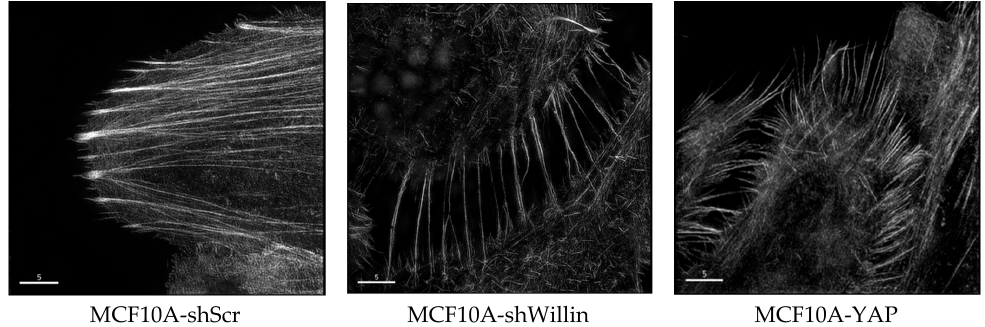
Figure 2. Structured illumination microscope images of Fluor568 phallodin stained actin cytoskeleton of MCF10A cells expressing either shScr (scramble control), shWillin or YAP, indicating that a knockdown of willin expression appears to phenocopy increased YAP ‐ induced filopodia formation [63]. Images taken by Dr S Moleirinho and Dr M Posch (University of Dundee) on an OMX microscope (scale bar, 5 μ m).